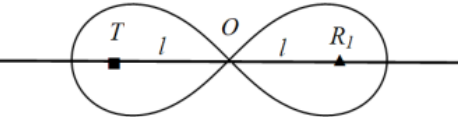
Figure A1. Maximum placement interval of T − R n when n = 1. (Square denotes transmitter and triangle denotes receiver.).